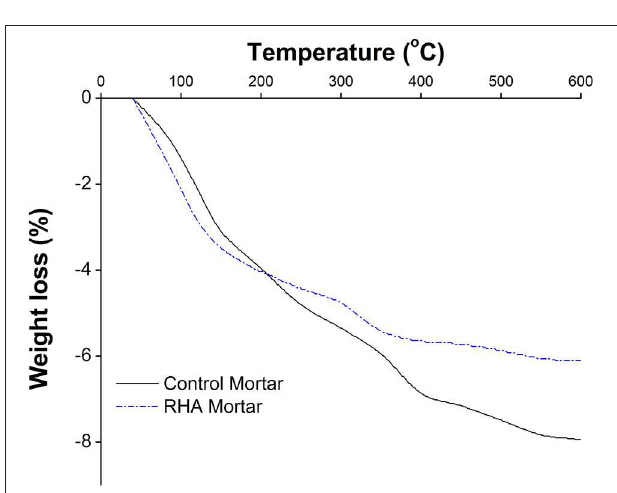
FIGURE 12 | Comparison of thermogravimetric analysis between control mortar and mortar containing 15%